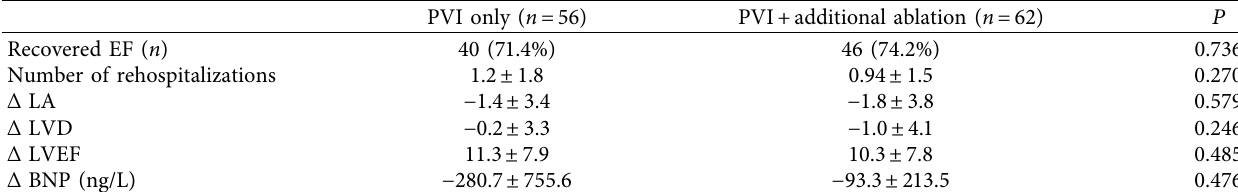
Table 2: Clinical outcomes of the patients and changes in TTE parameters and BNP.